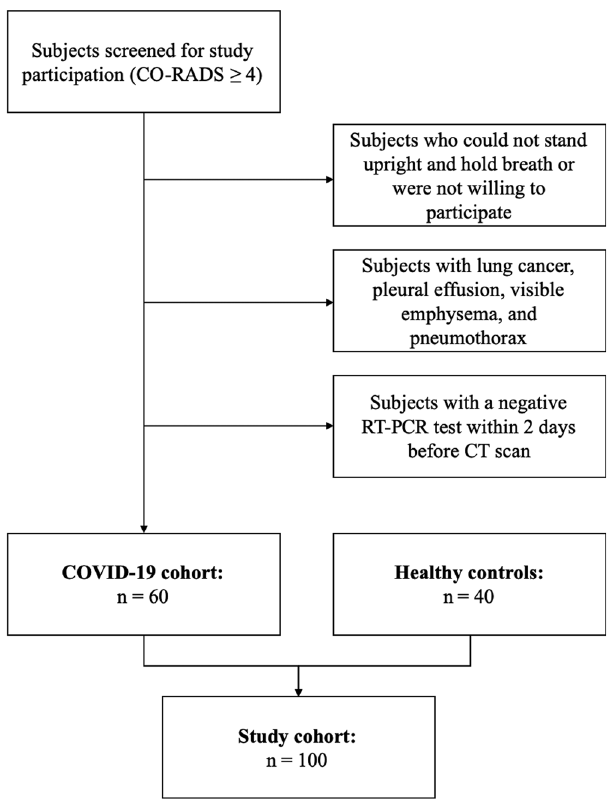
Fig. 1 Flowchart illustrating patient selection. Subjects with a CO-RADS category ≥ 4 were screened for study participation. Taking into account the exclusion criteria, 60 participants were included in the COVID-19 cohort. Forty healthy subjects formed the control